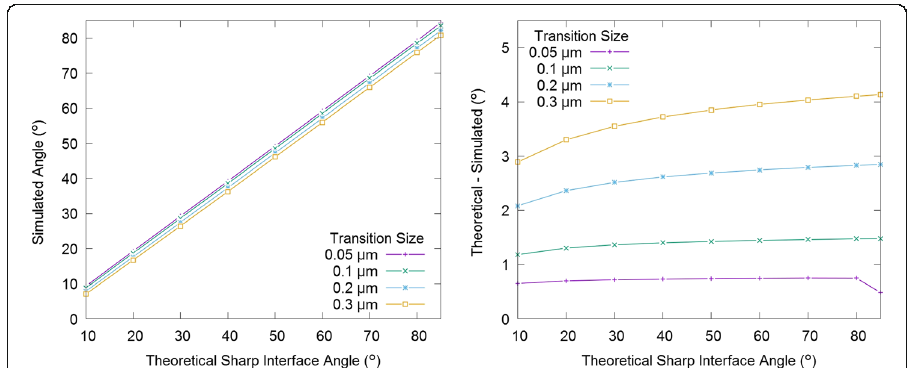
Fig. 7 Left : plot of contact angles calculated from gradient of simulation as a function of the theoretical sharp interface angle for the transition sizes between 0.05 and 0.3 μ m. Right : the difference between the theoretical and simulated contact angles from the figure to the left Fig. 8. Due to symmetry, the centre of the sphere defining the boundary of the bubble is lo- cated along the axis of symmetry (i.e. r = 0) displaced below the origin a distance Z contact angle can be found done using the bubble height at the origin, h any other location on the sphere, h ( r ). Using this methodology, the intersection angle of this sphere with the h = 0 axis can be calculated according to r 2 þ h r ð Þð Þ 2 þ h 0 ð Þ 2 Z 0 ¼